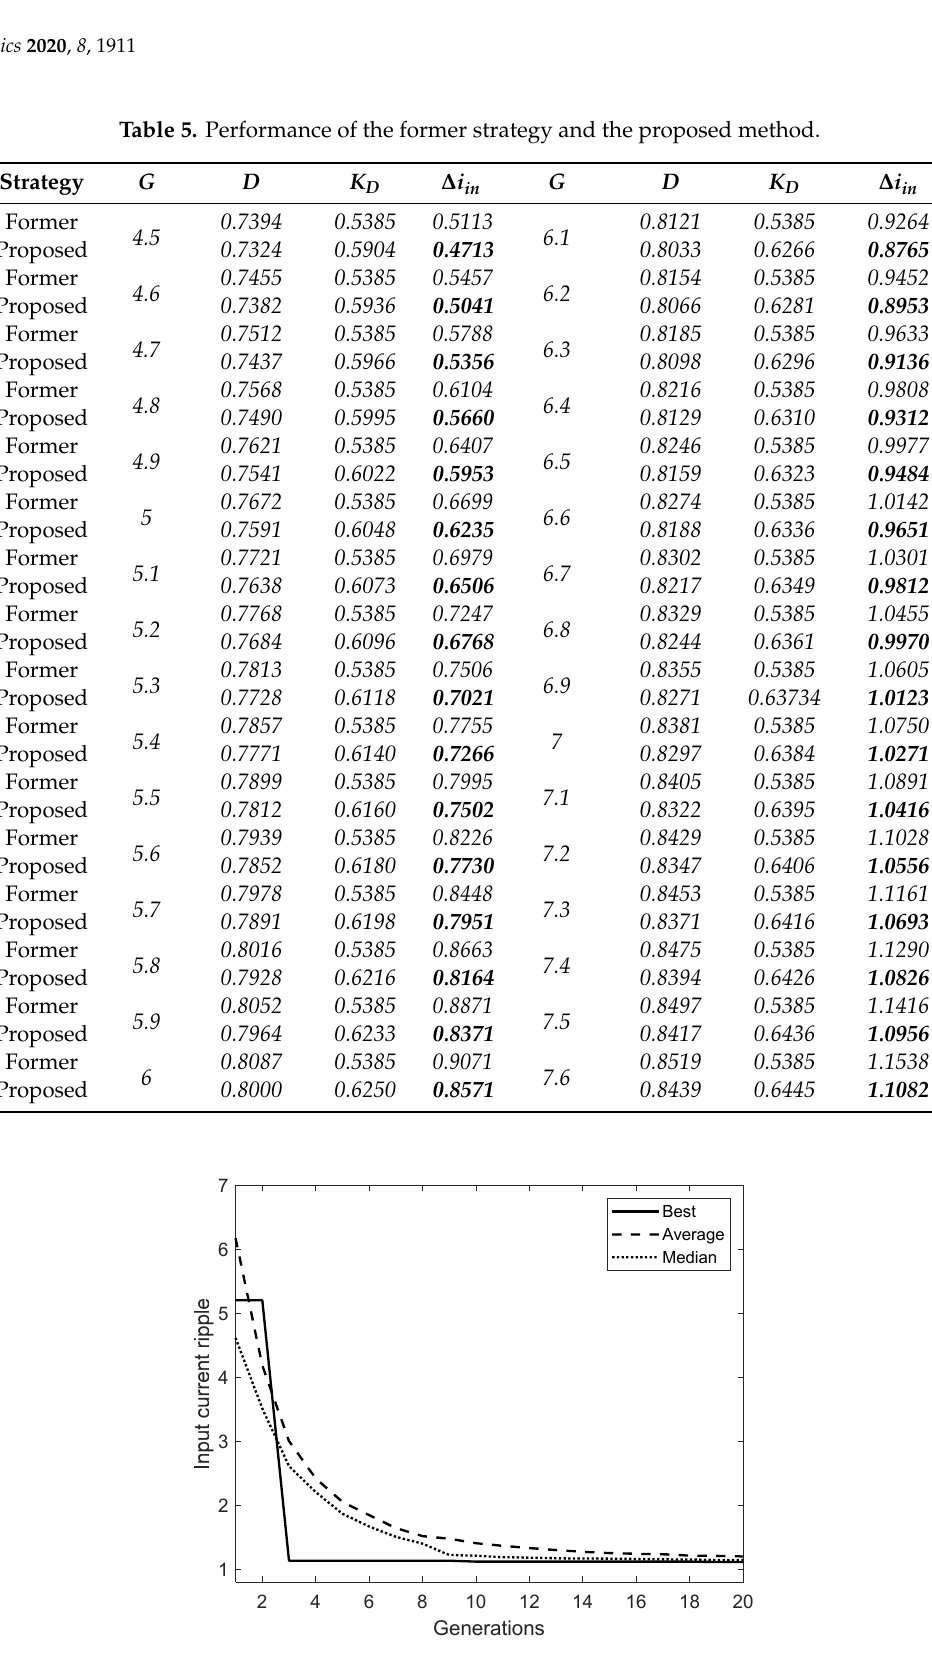
Figure 13. Convergence graph of L-SHADE considering G = 7.5 in 100 independent executions.